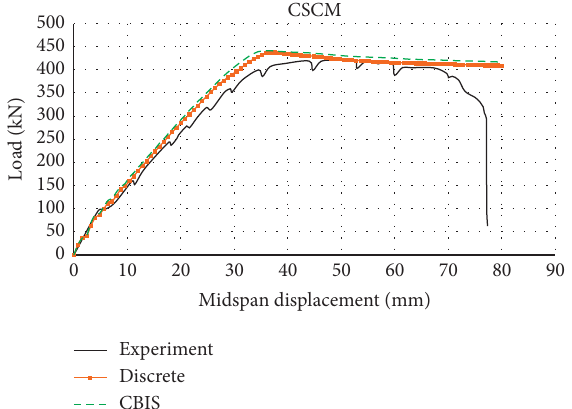
Figure 12: Comparison of the discrete model and CBIS model when CSCM concrete material option is